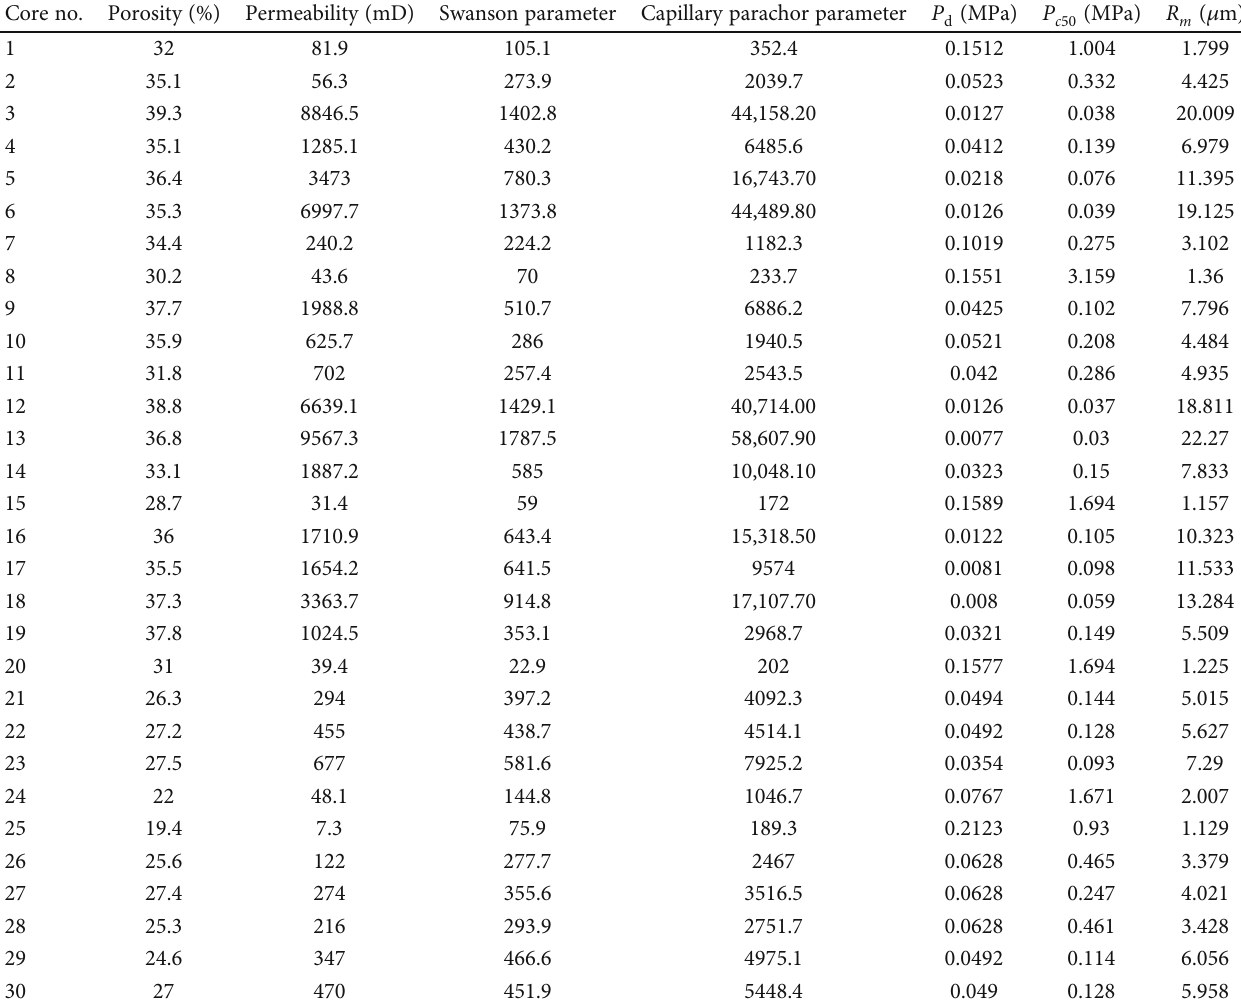
Table 1: Data for the thirty core samples that have been studied in this work (Liu et al.